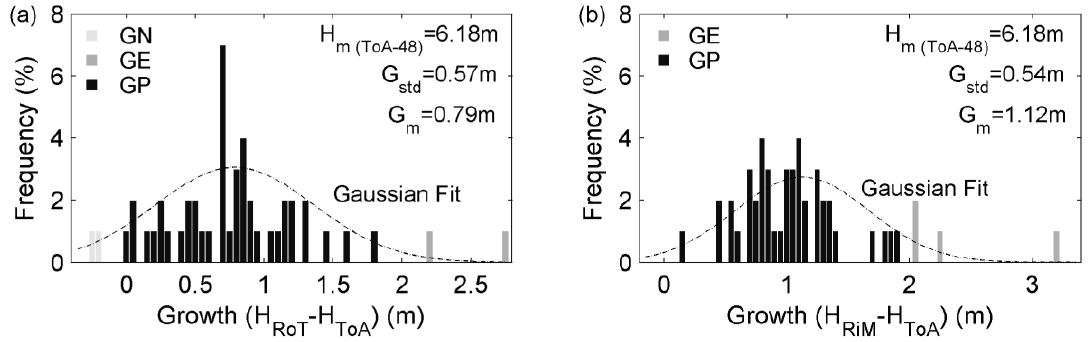
Figure 5. Histogram of the height growths derived ( a ) from the ToA and RoT